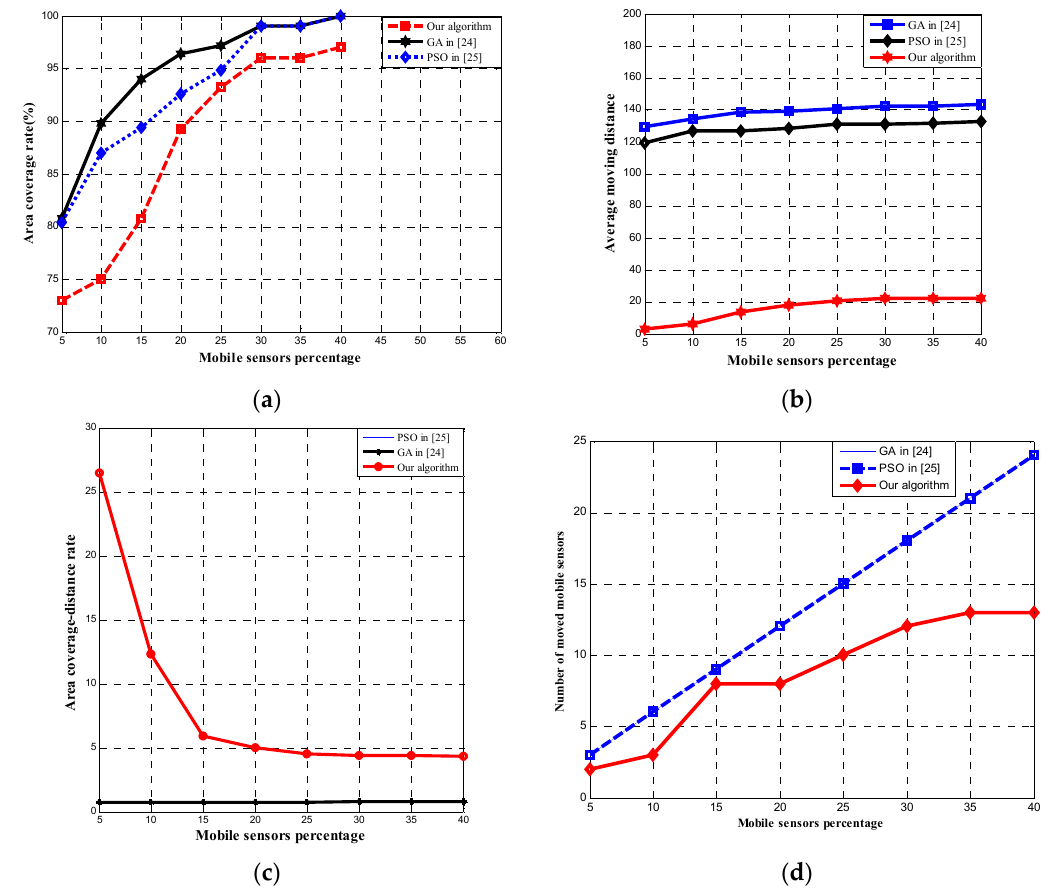
Figure 7. Results of the three algorithms on hybrid wireless sensor networks (WSNs) with different mobile sensors percentage. ( a ) Area coverage rate of the three algorithms; ( b ) average moving distance of the three algorithms; ( c ) area coverage–distance rate of the three algorithms; ( d ) the number of moved mobile sensors of the three algorithms.